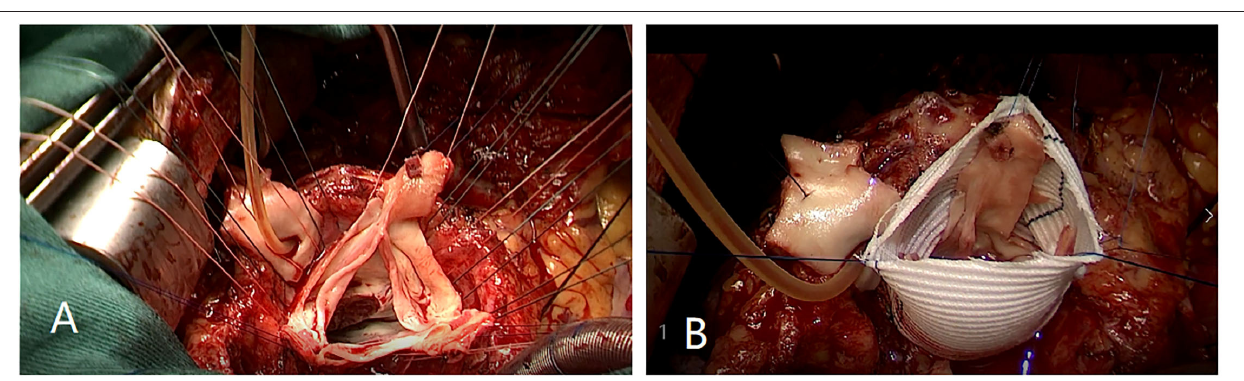
FIGURE 3 | (A) Aortic root was cut 3mm above annulus. (B) Each cusp of leaflets was fixed within the artificial graft by horizontal mattress suture during proximal